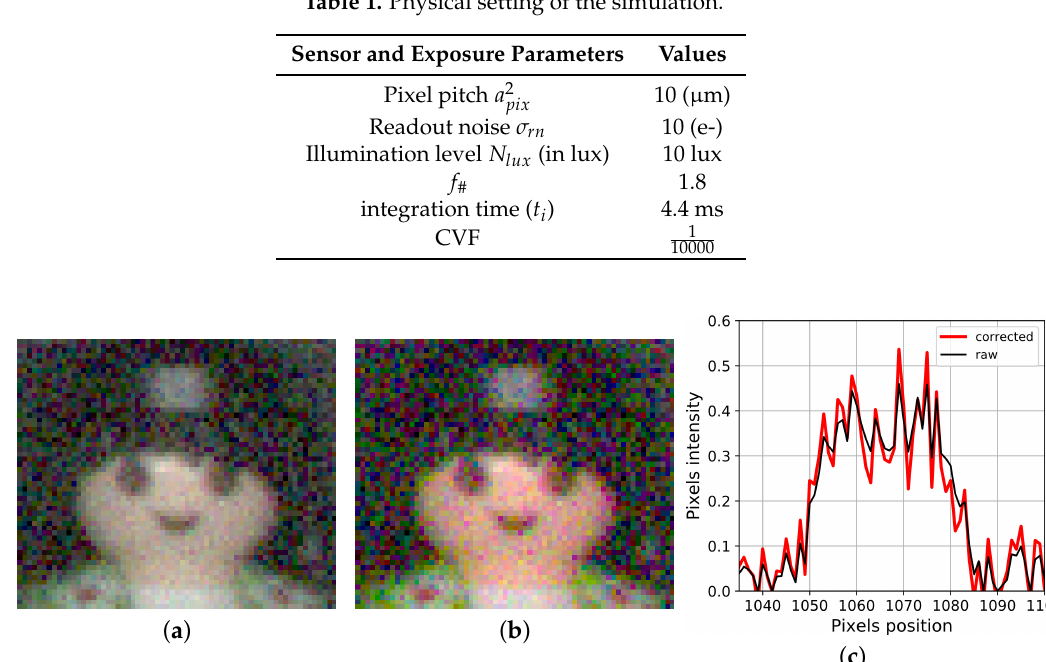
Figure 3. ( a ) Noisy raw image, ( b ) Image after color correction. ( c ) Intensity profile of the green channel at the horizontal